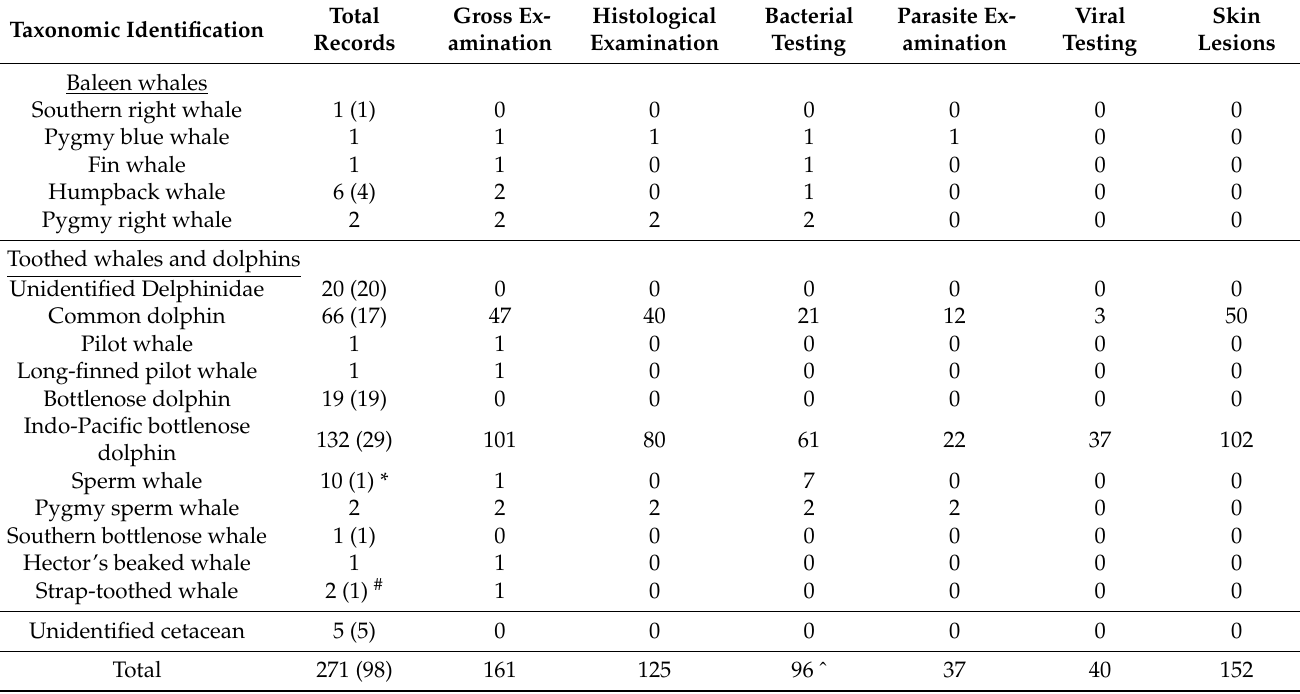
Table A1. Summary of records of cetacean strandings and mortalities in the St Vincent Gulf Bioregion, South Australia, during 2009–2020. Numbers in parentheses are the non-specimen records and included in the total to the